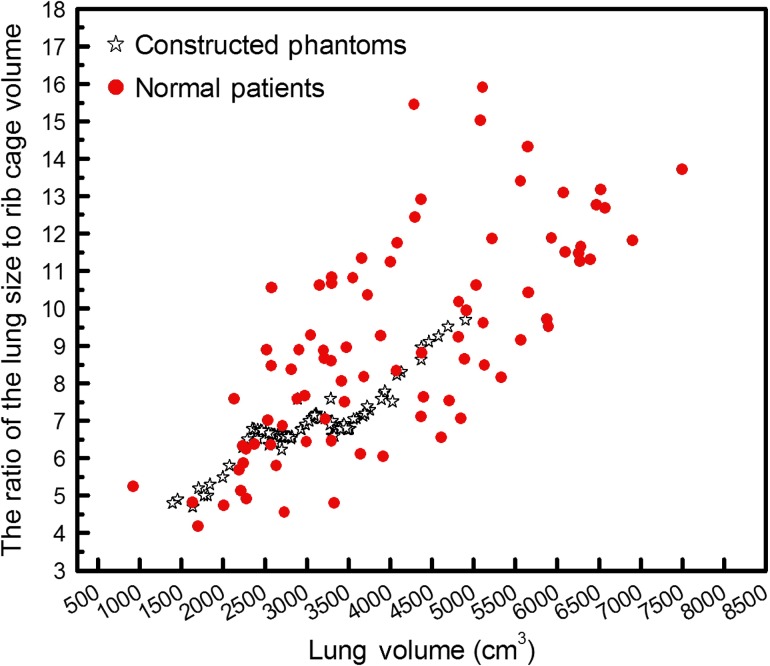
This scatter plot shows the correlation between lung size and rib cage volume for normal patients and constructed phantoms.